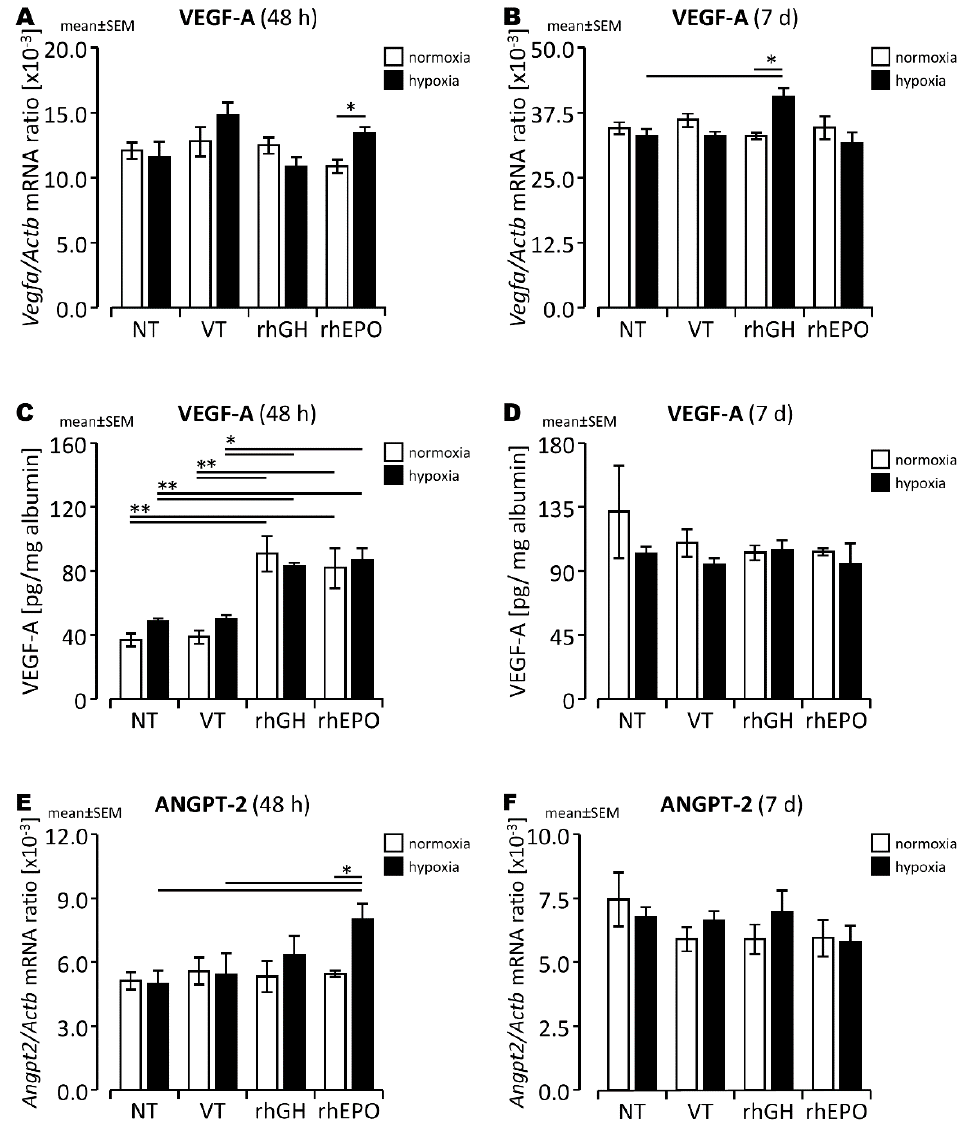
Figure 1. VEGF-A gene ( A , B ) and protein ( C , D ) expression and Angpt-2 gene expression ( E , F ) in normoxic and hypoxic developing mouse brains after a regeneration period of 48 h ( A , C ) or 7 d ( B , D ). *, p < 0.05; **, p < 0.01.